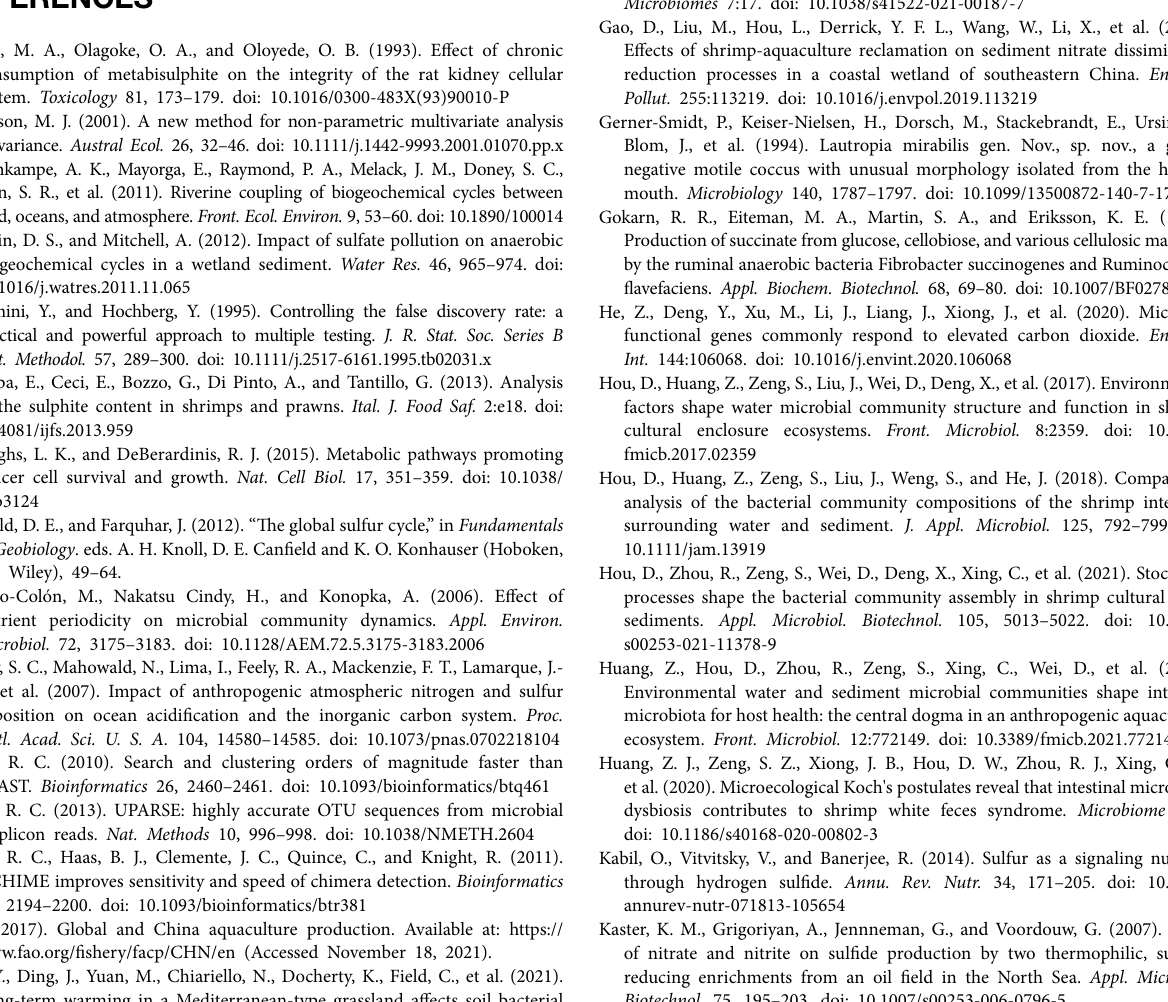
Supplementary Figure S1 | Taxonomic composition of functional gene host. Supplementary Figure S2 | Alpha-diversity of functional genes. The columns and deviation bars indicate the mean ± SD. Supplementary Figure S3 | The signal intensity of biogeochemical functional genes in GeoChip, (A) phosphorous, methane metabolism, and carbon fixation